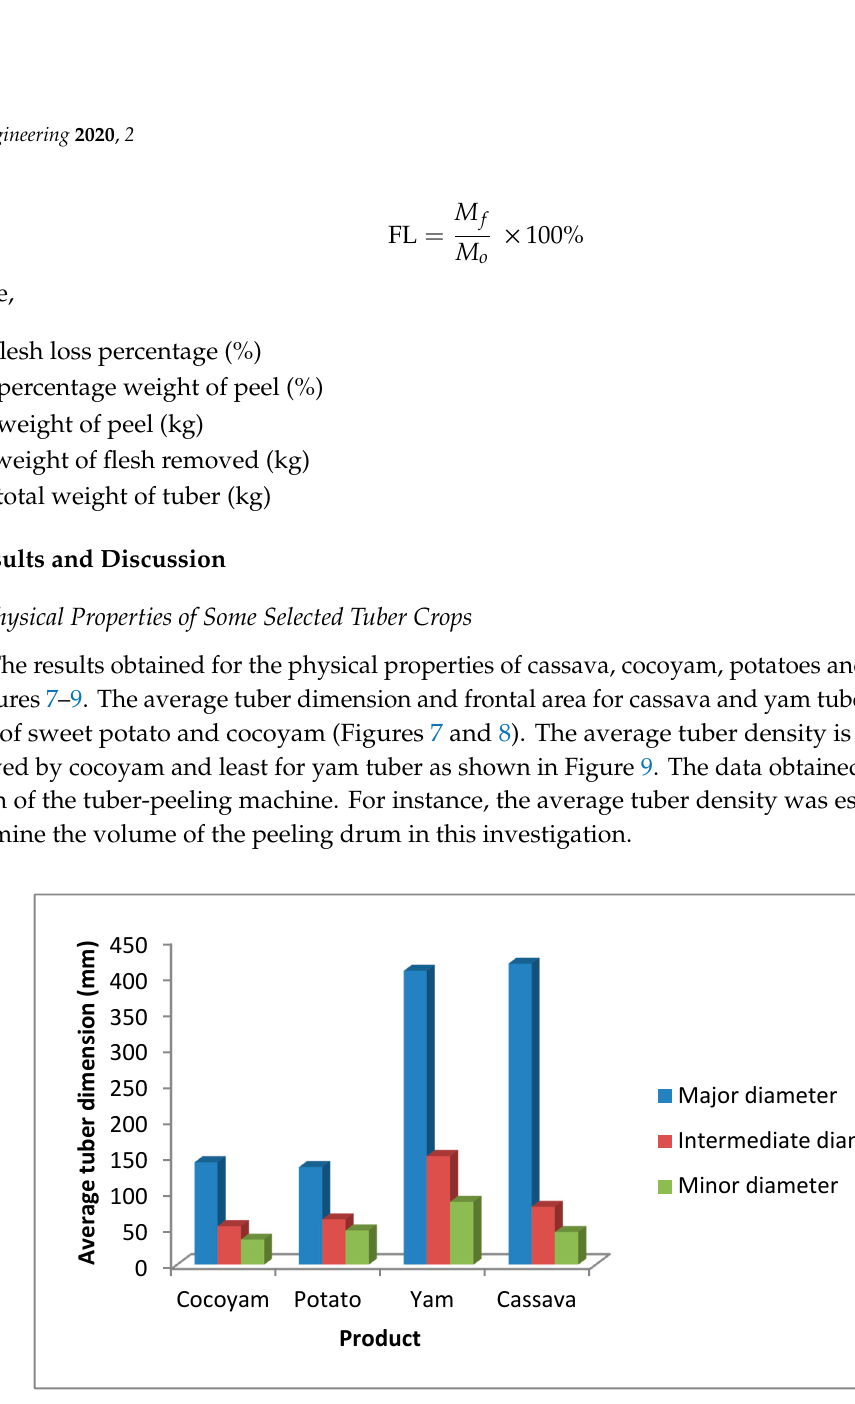
Figure 7. Comparison of tuber axial dimensions.